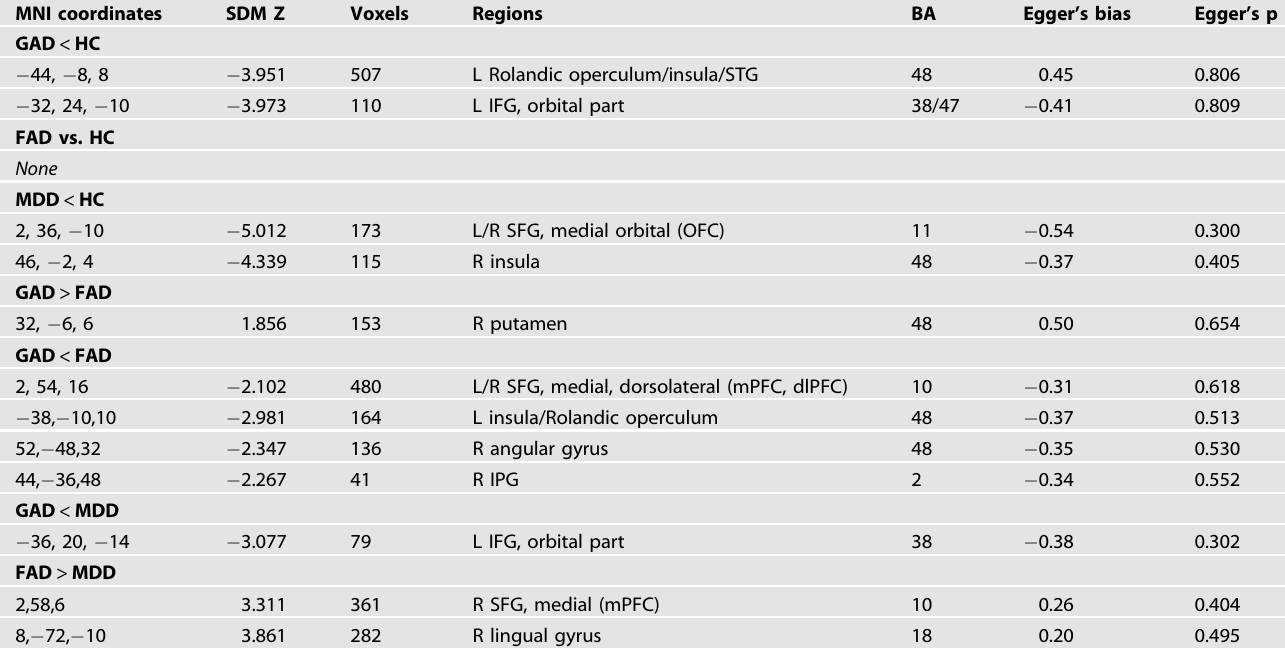
Table 4. Whole-brain meta-analysis results for VBM studies in GAD, FAD and MDD at threshold TFCE p <